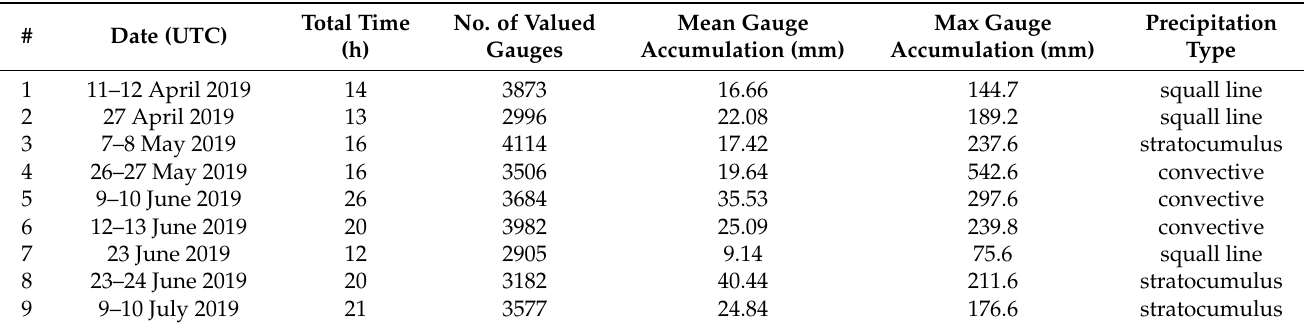
Table 2. Nine rainfall events used in this study.